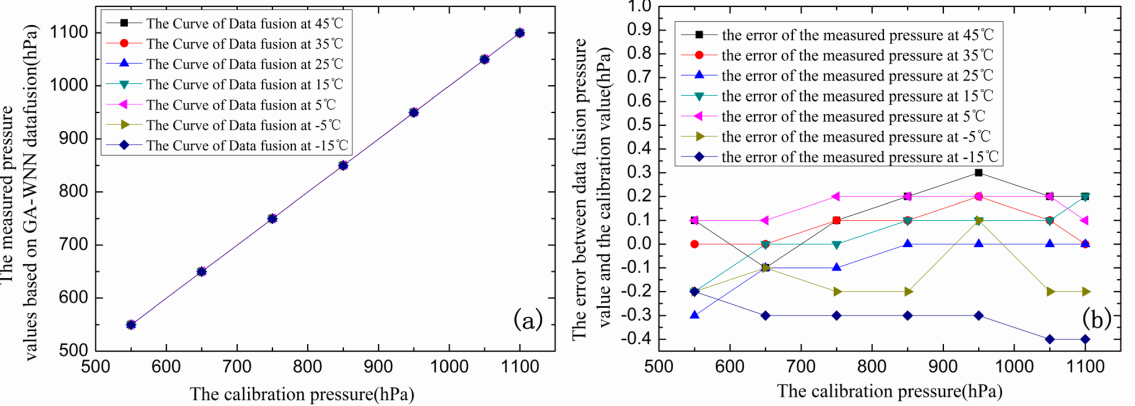
Figure 7. ( a ) Dependence of the output voltages of MEMS-array pressure sensors without compensation on the temperatures with pressures from 500 to 1100 hPa. ( b ) Dependence of corresponding calibrated pressure values after correction through GA-WNN data fusion on the temperatures under different pressure. ( c ) The relationship curves between the corrected pressures and the calibration pressures with temperatures from − 20–50 °C. ( d ) The absolute error between the corrected pressures and the calibration pressures at different temperature.